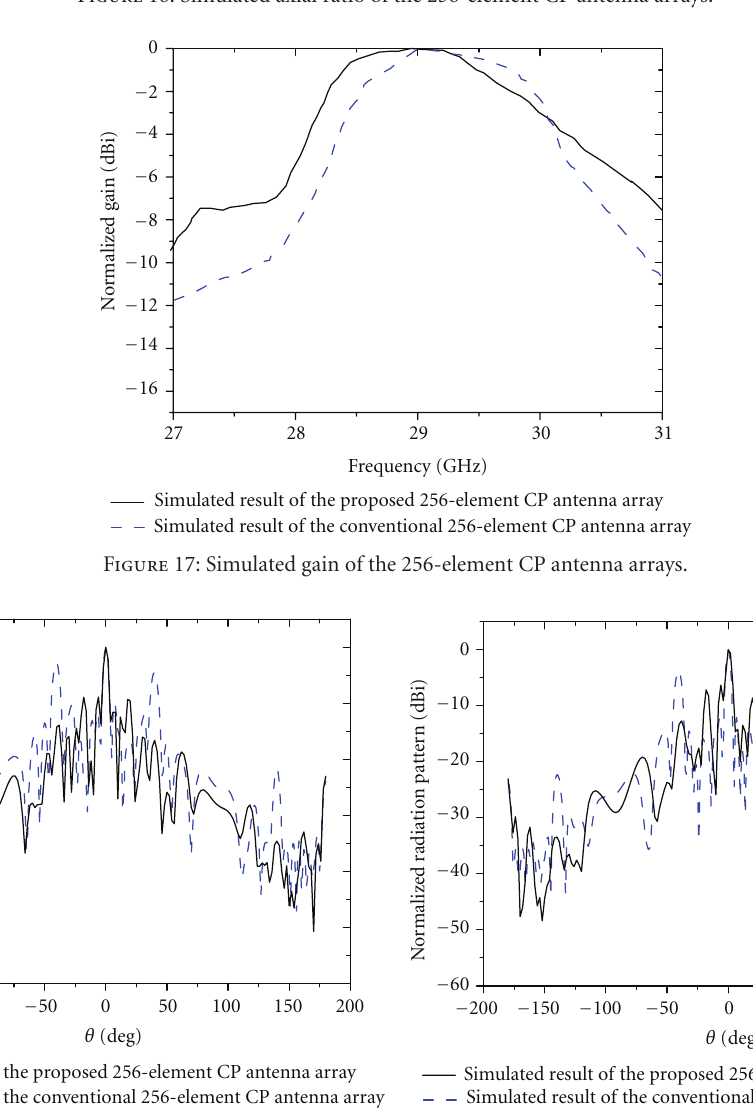
Figure 16: Simulated axial ratio of the 256-element CP antenna arrays.